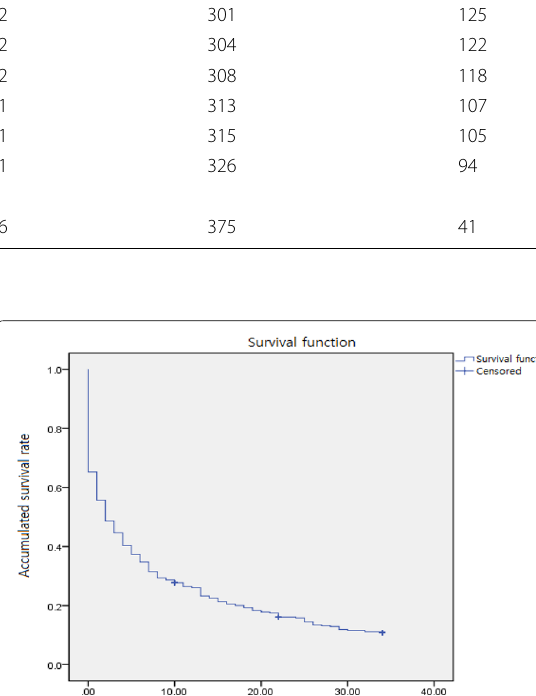
Fig. 1 Survival function for college graduates’ unemployment exit